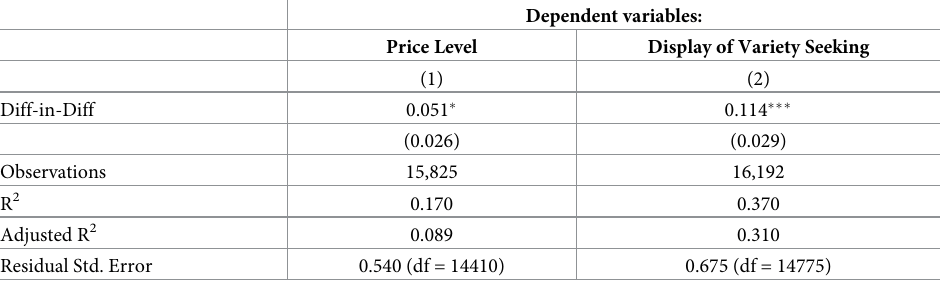
Table 3. Difference-in-differences estimates of achieving status on price level and display of variety